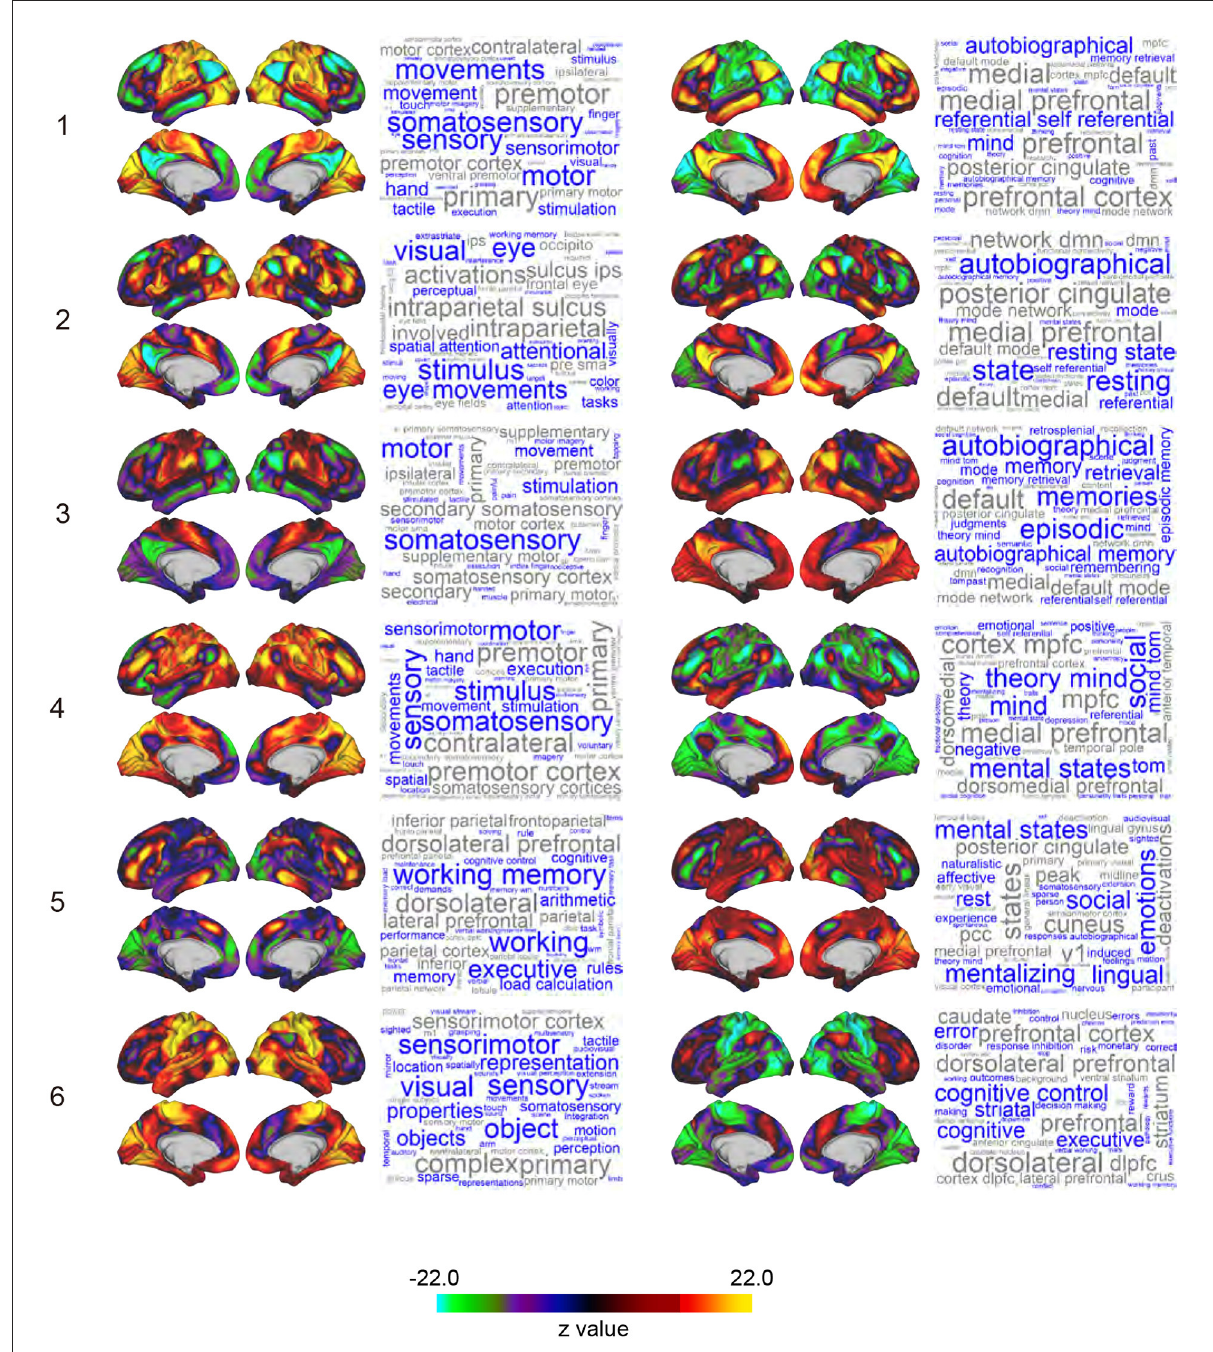
FIGURE2 Whole-brain maps of SAP. Z-values of signal magnitude were color-coded and mapped onto the 3D surface of the standard brain. Columns and rows indicate clusters (1-6) and pairs of sub-clusters (e.g., Sub-clusters 1-1 and 1-2). Each inset shows left lateral, right lateral, left medial, and right medial surfaces of the brain. Each SAP map is functionally characterized by a word cloud on the right based on a map-to-function decoder. The font size of a word represents the strength of similarity between the SAP maps and functional brain maps revealed by meta-analyses. Names of brain regions are colored in